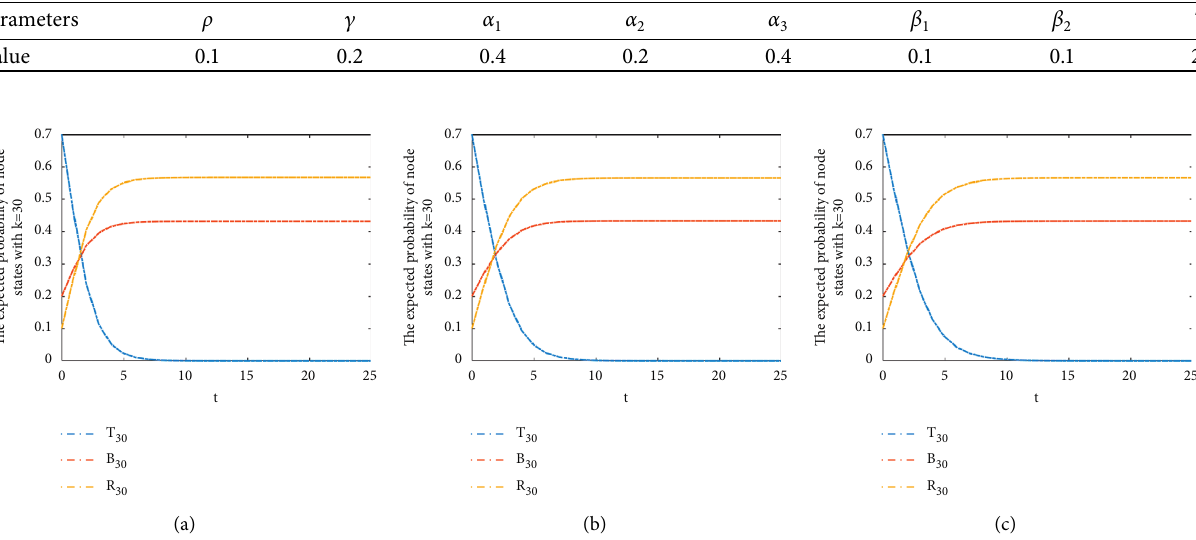
Figure 3: (a) Facebook network, (b) e-mail network, and (c) Twitter network. Table 3: Parameters based on the network.